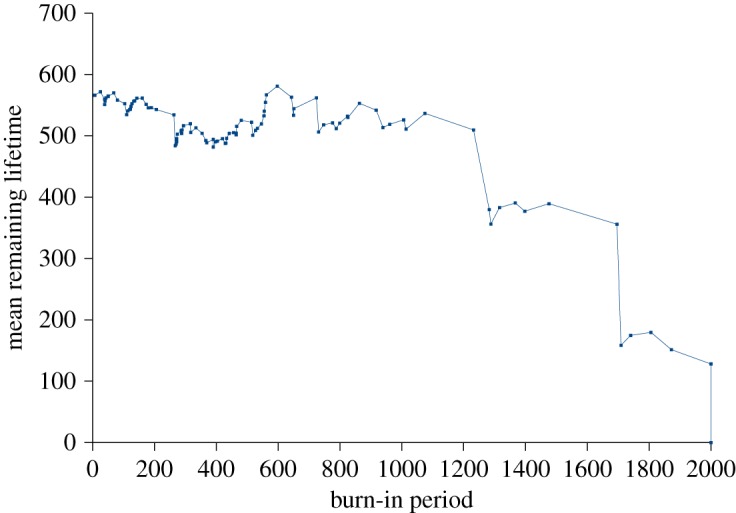
Mean remaining lifetime function of a typical run of the logistic map as previously described. Here, and throughout, the points are plotted at each failure event, as this information may also be informative to the reader.